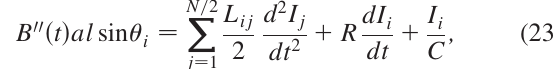
FIG. 8. (Color) The red line denotes the path to which Ampere’s law is applied. The approximation is made that the field on the x ¼ 0 plane is constant in the derivation of Eq. (25). The blue and orange objects represent the ferromagnetic yoke and the current conductors to produce the external magnetic field B ð t Þ ,